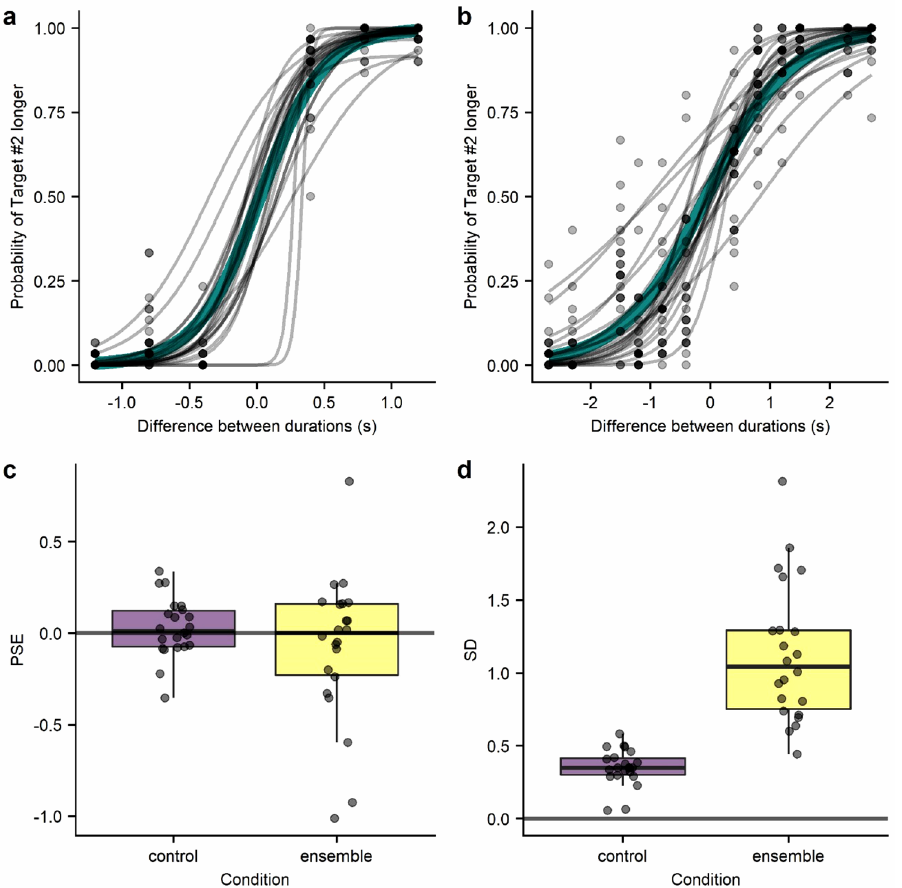
Figure 4. Psychometric curves of every participant in the control condition ( a ) and ensemble condition ( b ). Each grey line represents a different observer, and green thicker lines show the fit to the aggregated data from all participants. Comparison between the estimated Point of Subjective Equality (PSE) ( c ) and Standard Deviation (SD) ( d ) of the psychometric curves from each participant in the control and ensemble